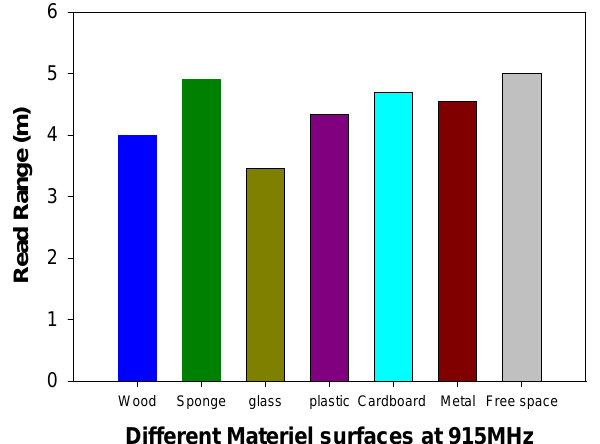
Figure 11: Measured Read range of the proposed RFID tag antenna mounted on different materials in real conditions